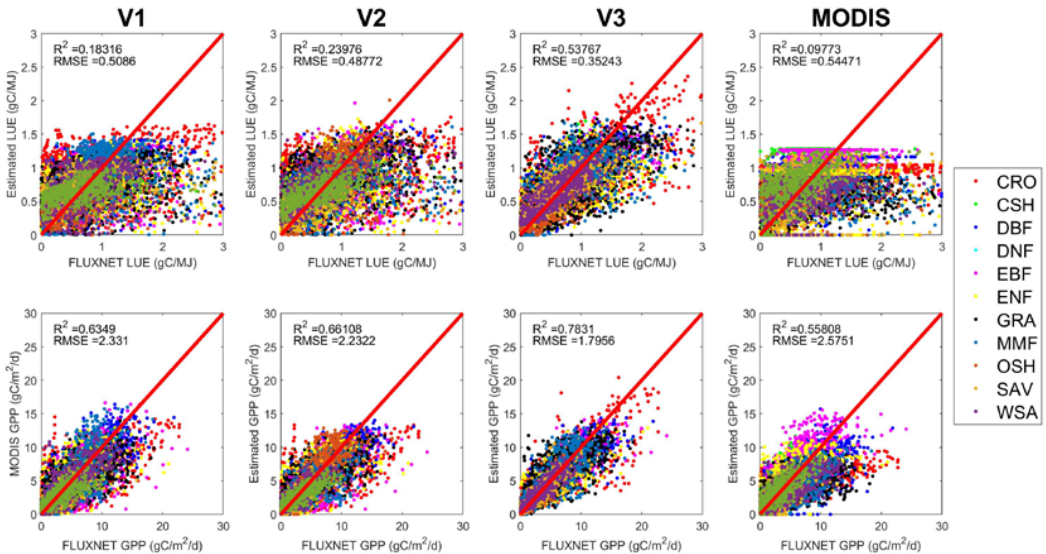
Figure 2. The validation results of 3 approaches. Approach V1: Parameterization approach without the clearness index (CI); Approach V2: Parameterization approach with the CI; Approach V3: Cubist regression tree approach; MODIS: MODIS 17 algorithm.